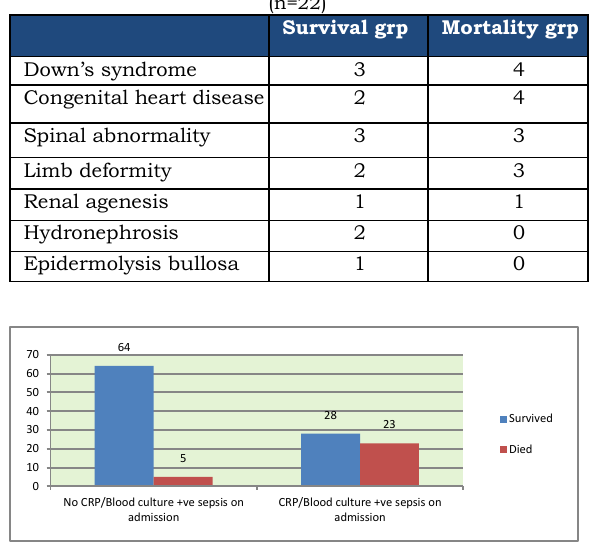
Figure 2: Outcome of patients as per presence or absence of CRP/ blood culture positive sepsis on admission. However, on statistical analysis, the associated GCA was not a statistically significant risk factor for mortality in our series. Eighty-seven patients pre- sented with hypothermia on arrival, of those 24 died. The mortality rates in the “hypothermia on arrival group” and “no hypothermia on arr ival group” were 27.58% and 12.12% respectively. The mortality rates in the “sepsis on admission group” and “no sepsis on admission group” were 45% and 7.2% which was statistically significant with a p- value of 0.0001 (Figure 2).